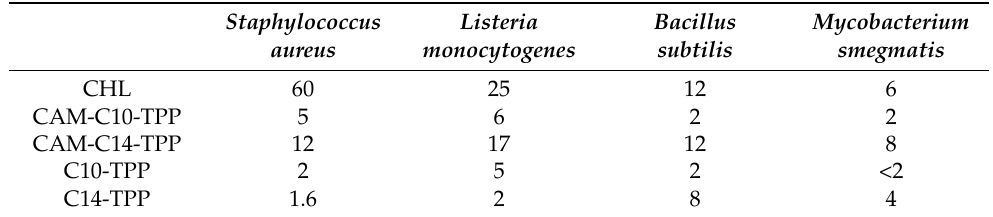
Table 1. Suppression of the growth of Gram-positive bacteria by CAM-Cn-TPPs. Values of the minimal inhibitory concentration (MIC, µ M) are shown 1